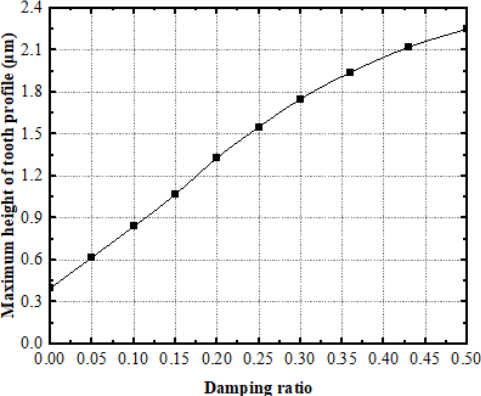
Figure 9. The influence of damping ratio on the maximum height of face gear.